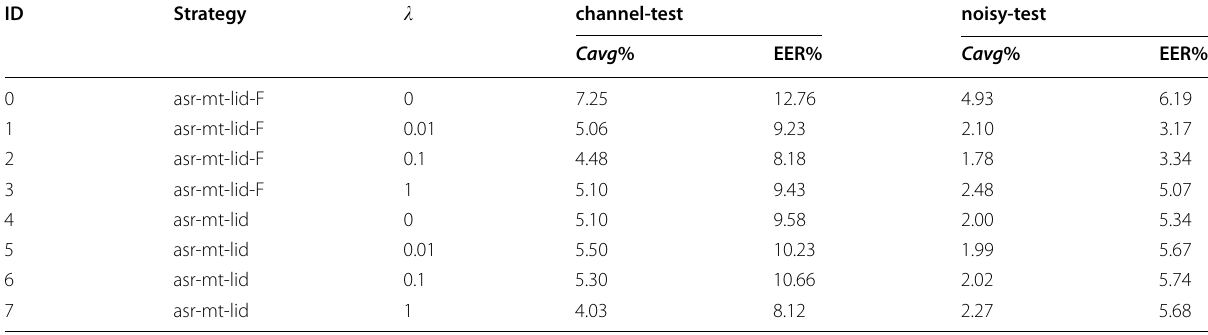
Table 5 Experimental results with different values of the hyperparameter (cid:31)